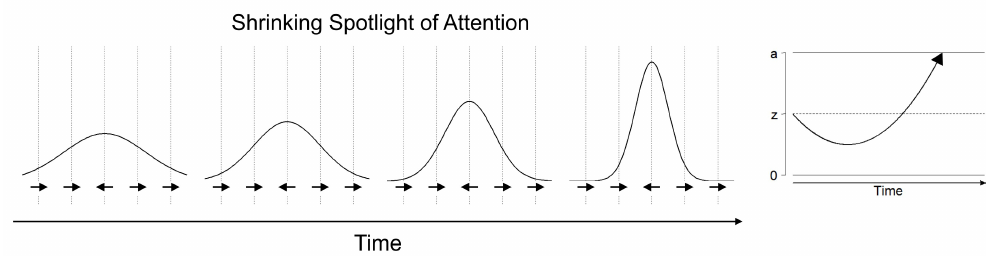
Figure 3. Illustration of the Shrinking Spotlight model for selective attention. The attentional focus narrows to the central arrow over time ( left part ). This results in a stronger weight of the critical information (i.e., the central stimulus) in the drift-rate of an associated diffusion process ( right part